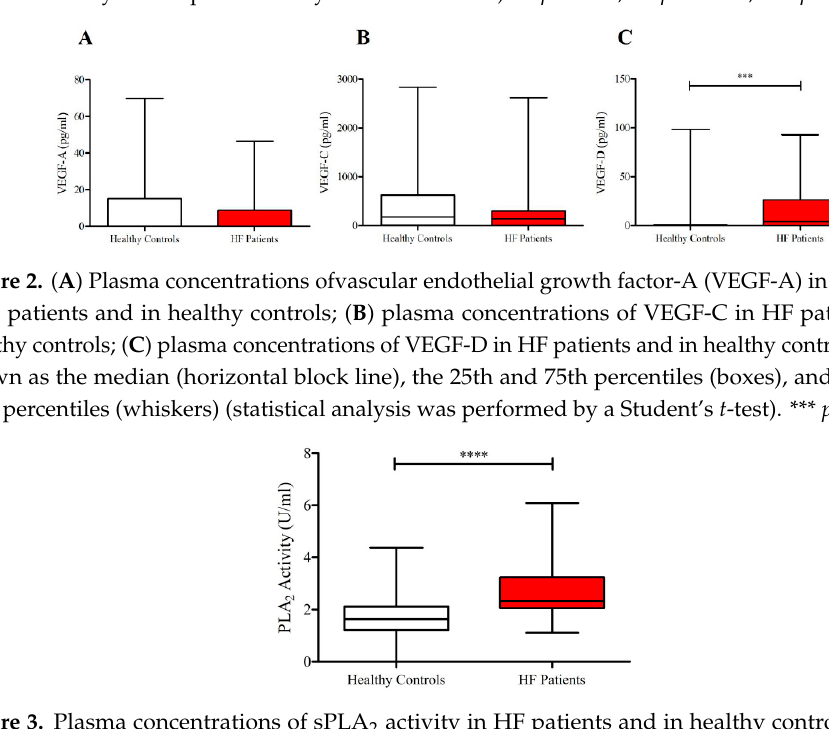
Figure 3. Plasma concentrations of sPLA 2 activity in HF patients and in healthy controls. Data are shown as the median (horizontal block line), the 25th and 75th percentiles (boxes), and the 5th and 95th percentiles (whiskers) (statistical analysis was performed by a Student’s t -test). **** p <